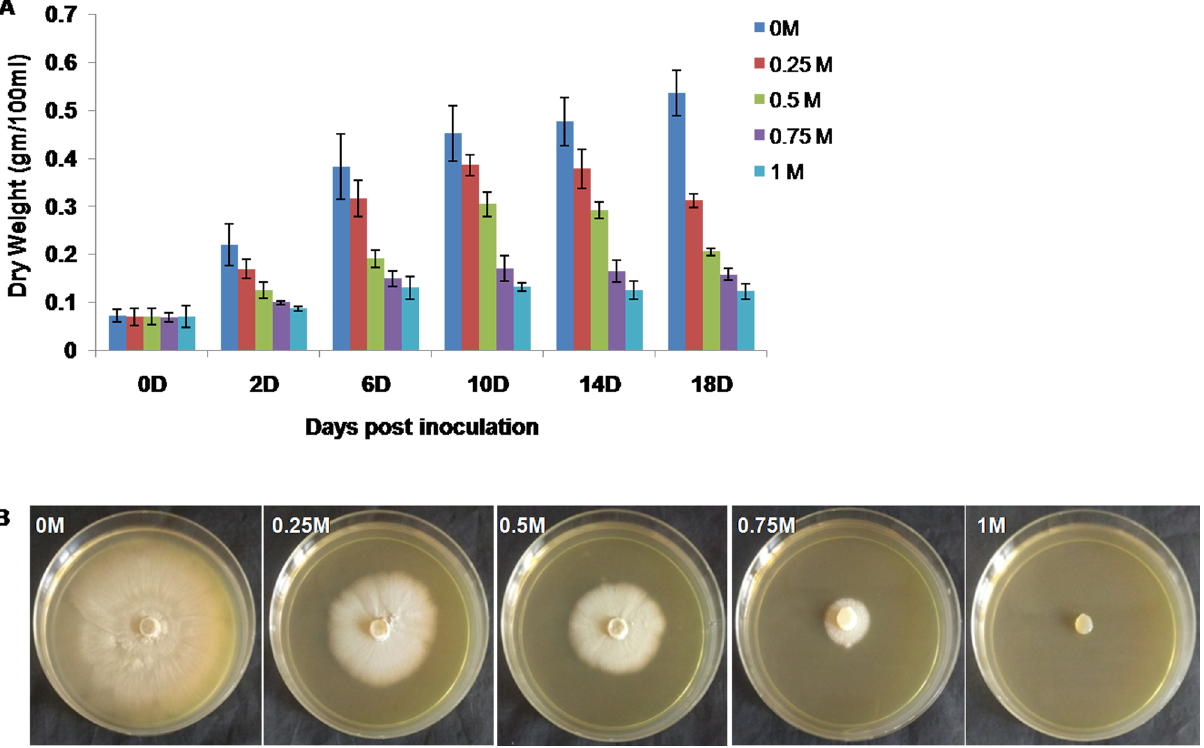
Figure 1. ( A ) Growth of P. indica under various NaCl concentrations over a different time interval. Fungal dry weights were measured at 0, 2, 6, 10, 14, and 18 days after treatment with salt (0 M, 0.25 M, 0.5 M, 0.75 M, and 1 M NaCl).Values represent means with ± standard deviations (SD) of three replicates. ( B . Stress sensitivity of P. indica grown under different salt concentrations on Kaefer’s agar medium for 10 days. Each panel shows different salt treatment, i.e. 0 M, 0.25 M, 0.5 M, 0.75 M, and 1 M